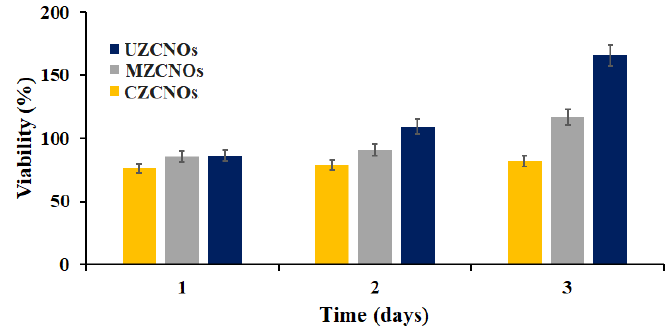
Figure 7. Cell viability of CZCNOs, MZCNOs, and UZCNOs composite hydrogels. Data represent mean ± SD ( n = 3). Statistically significant difference ( p < 0.05) was observed between the cell viability parameters of CZCNOs, MZCNOs, and UZCNOs samples.